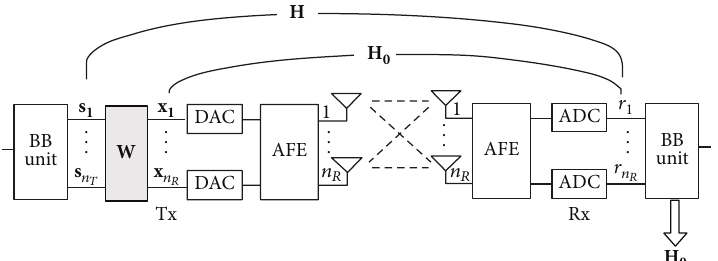
Figure 1: Proposed scheme using linear signal processing at the Tx. AFE denotes the analog front end, BB denotes baseband, and the DACs and ADCs are the digital-to-analog and the analog-to-digital converters,